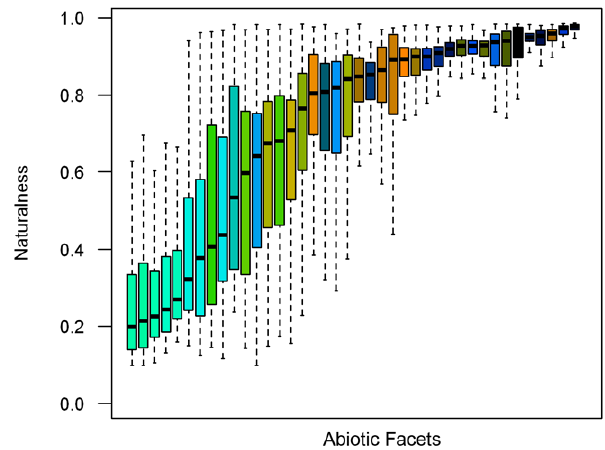
Figure 4. Boxplot of the naturalness of each facet. Each boxplot represents the naturalness (i.e., the proportion of natural land cover types) of each grid cell of each abiotic facet. The boxes are ordered on the x-axis by the increasing median naturalness of each facet (represented by the solid black line within each box) and are colored according to the relative positions of each facet on ordination axes from the correspondence analysis in Figure 3. Boxes represent the values between the 25th and 75th percentiles of naturalness of each abiotic facet. The dashed whiskers represent values that are 1.5 times the interquartile range or the most extreme value if no values exist beyond 1.5 times the interquartile range. Values that are more extreme than the dashed whiskers are considered outliers and are not graphed. The facet corresponding with open water is not graphed because naturalness values for open water were missing and were estimated based on neighboring grid cells for analysis.